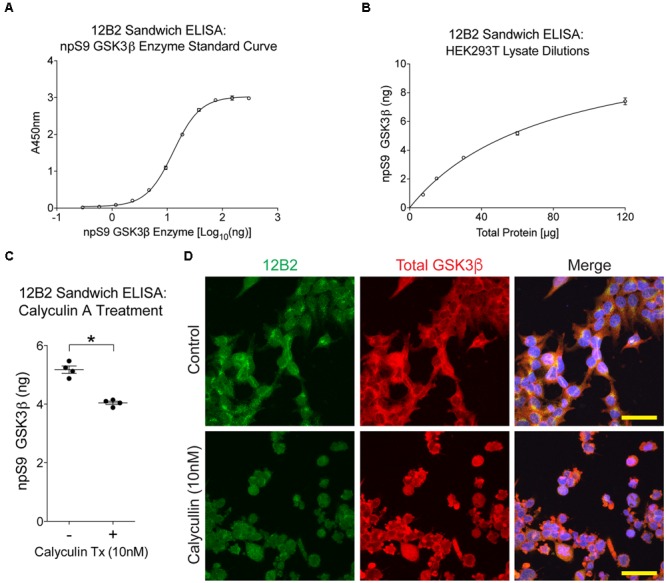
Treating cells with protein phosphatase inhibitor decreases npS9 GSK3β in cells. (A) A standard curve of dephosphorylated GSK3β protein captured with 12B2 antibody was used for quantitative sandwich ELISAs (r2= 0.999). (B) Untreated HEK293T lysates assayed in 12B2 sandwich ELISAs at 120, 60, 30, 15, and 7.5 μg total protein/well produces a linear dose response curve (r2= 0.988). Interpolation using the standard curve in (A) indicates that the lysate samples contain 7.4, 5.2, 3.5, 2.0, and 0.9 ng of npS9 GSK3β, respectively. (C) HEK293T cells were either untreated (-) or treated with 10 nM calyculin A for 30 min (+) to reduce npS9 GSK3β levels (n = 4 independent experiments). The lysates were used in 12B2 sandwich ELISAs. A significant reduction in npS9 GSK3β levels was detected in calyculin A (10 nM) treated cells compared to untreated cells (∗p < 0.05, unpaired t-test, two-tailed). The amount of npS9 GSK3β was quantitatively determined by interpolation using the recombinant GSK3β standard curve in (A). (D) Immunofluorescence for 12B2 (green) showed an apparent qualitative reduction in npS9 GSK3β levels in HEK cells treated with calyculin A when compared to control cells. Cells were also stained with total GSK3α/β (red) and DAPI. Scale bar = 25 μm.